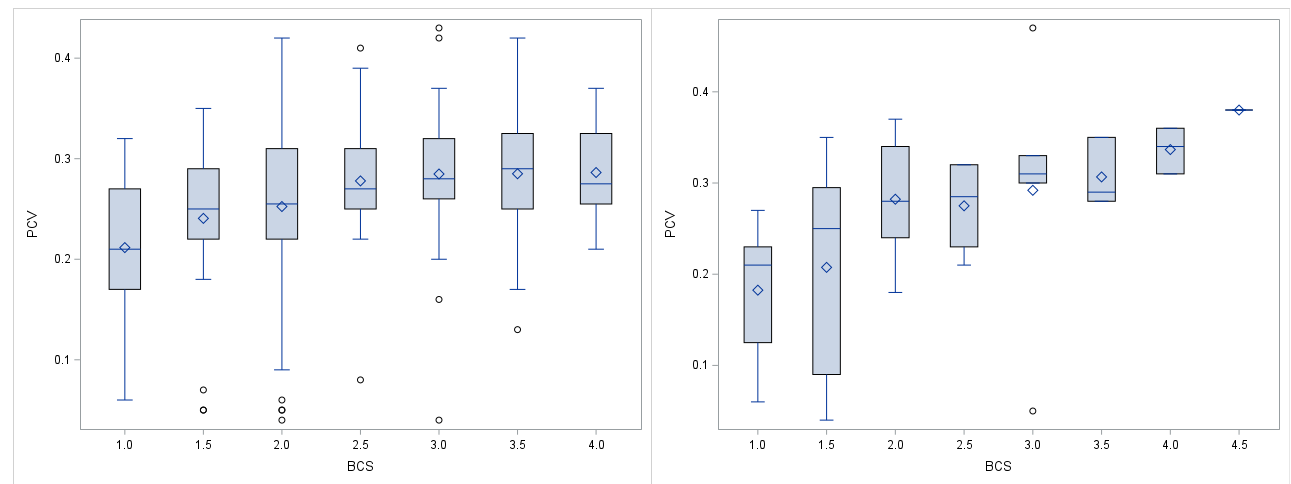
Figure 1. PCV in L/L in alpacas (n = 259, left ) and llamas (n = 41, right ) with different BCS. The boxplots display the quartile range and the respective minimum and maximum.